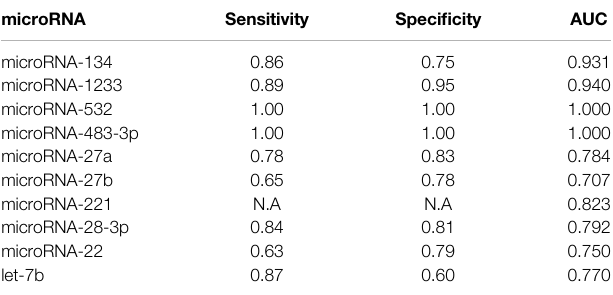
TABLE 1 | microRNAs ’ function and their characteristics from literature.